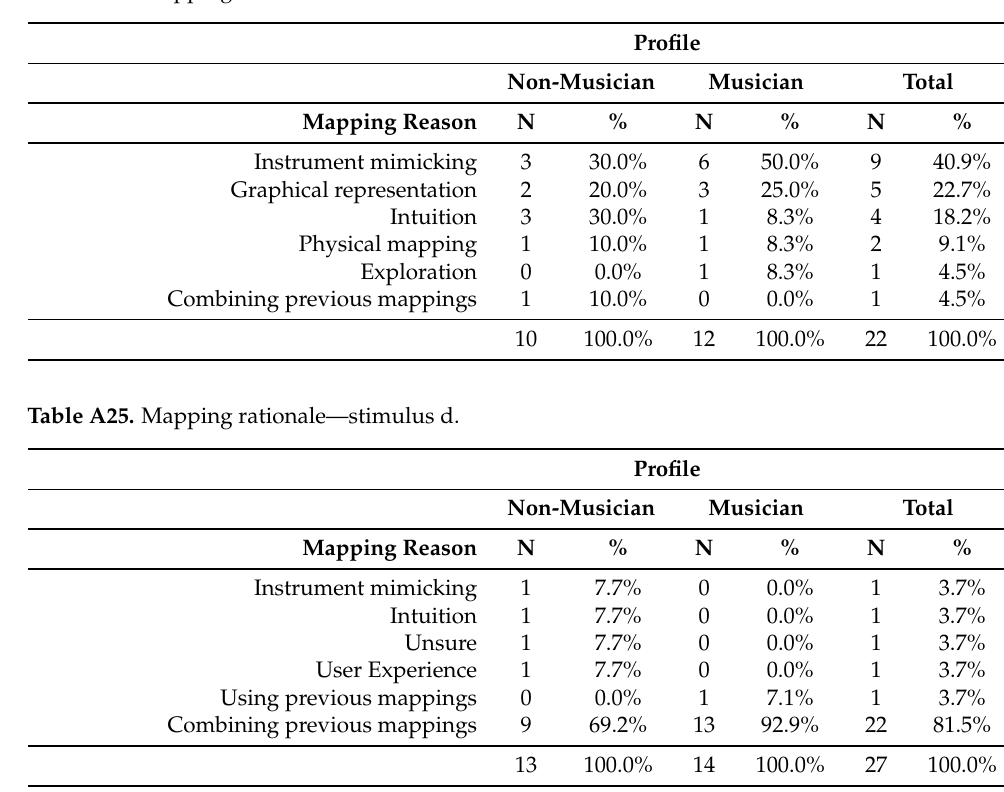
Table A24. Mapping rationale—stimulus c.